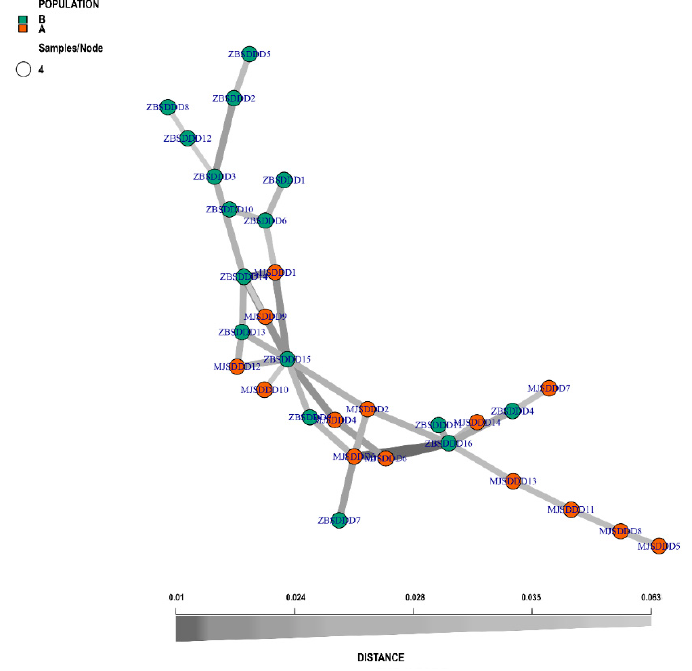
Figure 3. The minimum spanning network of 30 L. kasmira individuals.